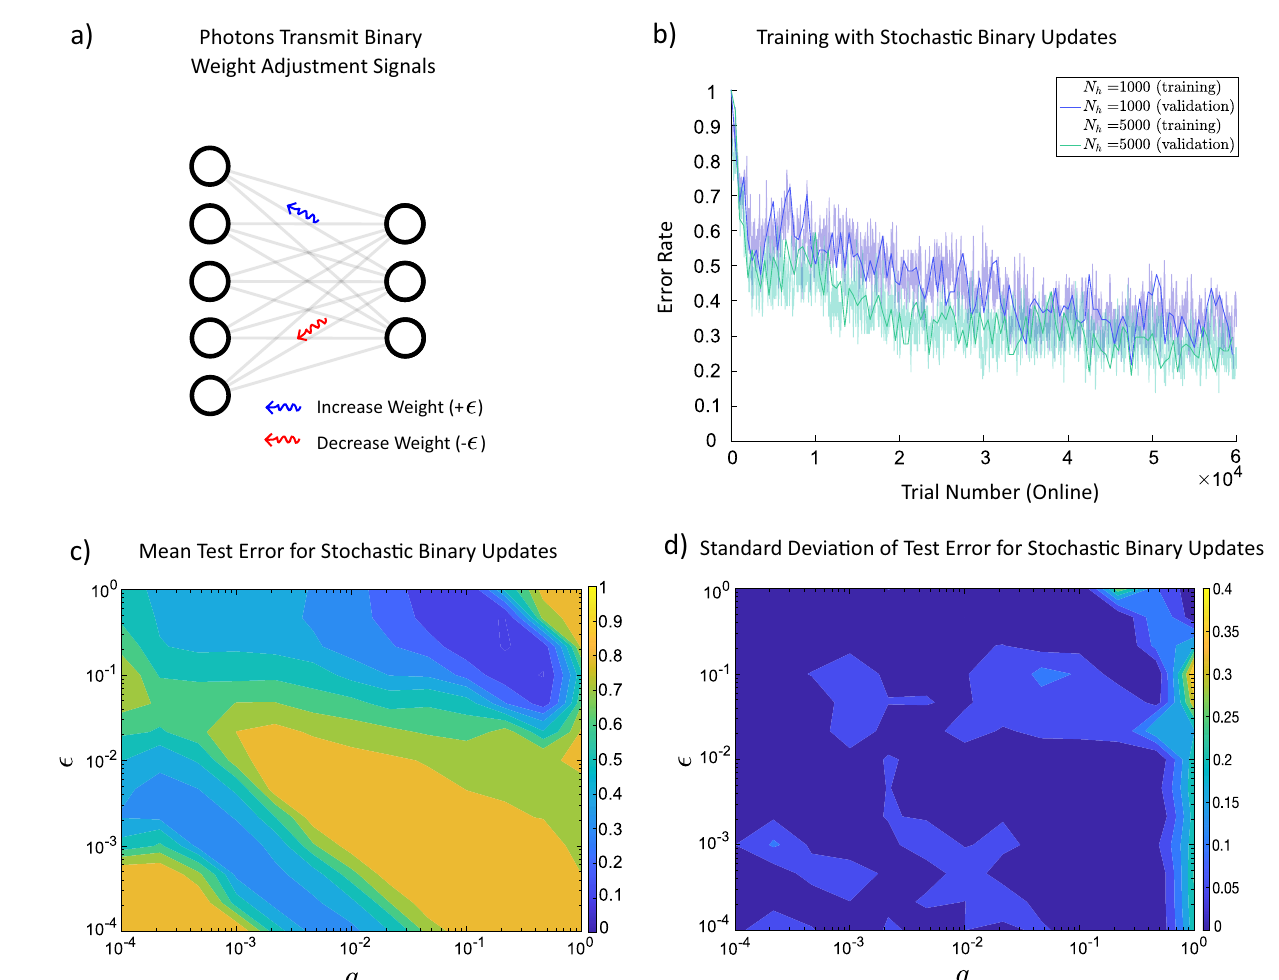
Figure 3. Training of a 3-layered artificial neural network by the stochastic photonic updates with carrying one bit of information. ( a ) Stochastic weight updates transmit binary information and each update either increases or decreases the weight by a fixed amount, ǫ . For more details see Eqs. (12) and (13) in “Methods”. ( b ) Here, q = 0.1 and ǫ = 0.1 . With stochastic binary updates, the training of MNIST classification task is still successful. As the number of hidden units increases the error rate converges to smaller values. ( c ) To obtain mean test error, for each values of ǫ and q , 10 different networks with 500 hidden units were evaluated and the test error was averaged. d, Standard deviation of the test error is calculated per mesh